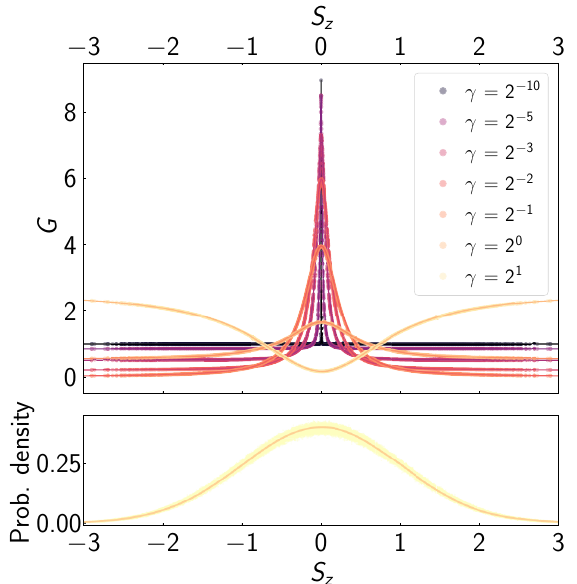
FIG. 10. Top: Amplification factor G after one Grover itera- tion for a single representative instance of weights at n = k =12. Fits with the Lorentzian model of Eq. (E1) are shown as solid lines. Offset B is the sole free fit parameter, which is related to A by Eq. (E7). Bottom: Initial S z probability density distribution for n = k = 12, averaged over 10 4 instances (yellow points with shading). Expected initial distribution, a Gaussian with σ S shown as a solid orange